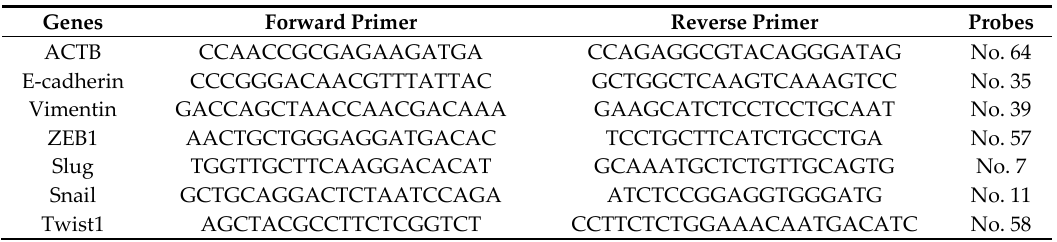
Table 3. Sequences of polymerase chain reaction